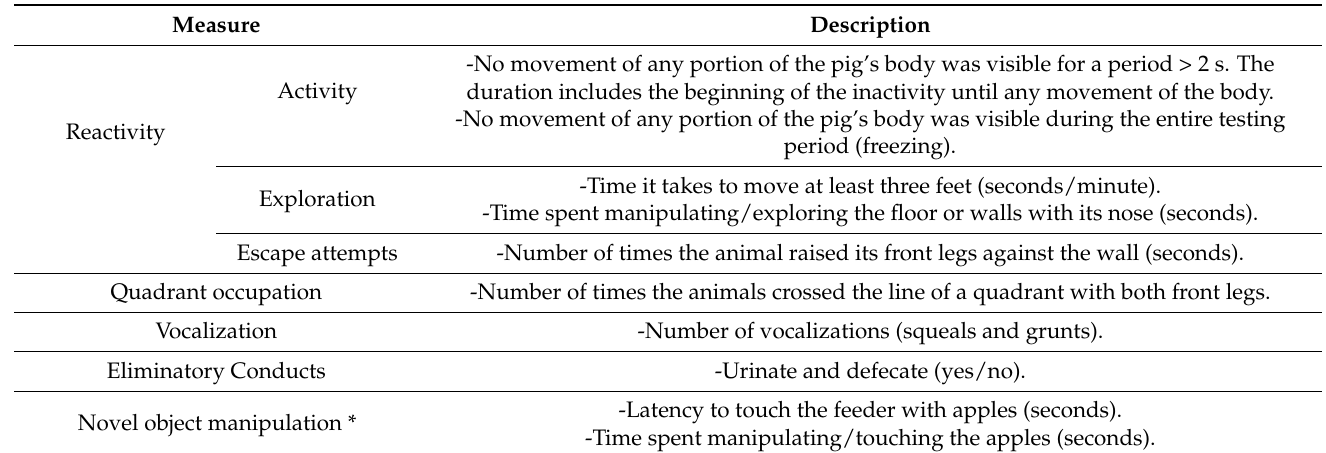
Table 2. Description of the behavioral measures for open field and novel object tests performed during the experimental